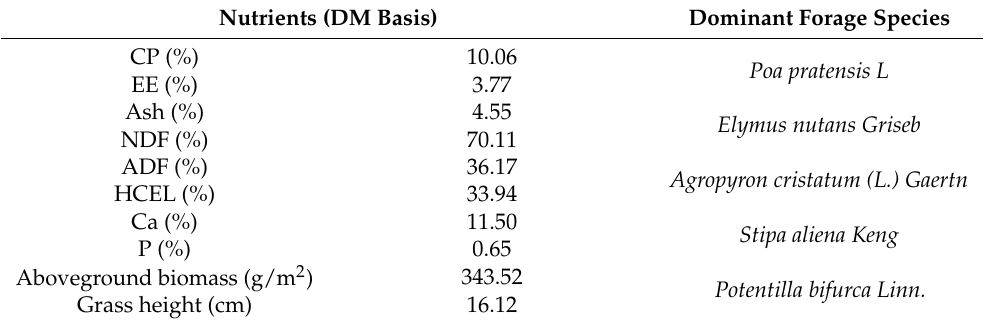
Table 3. Forage species and nutrient